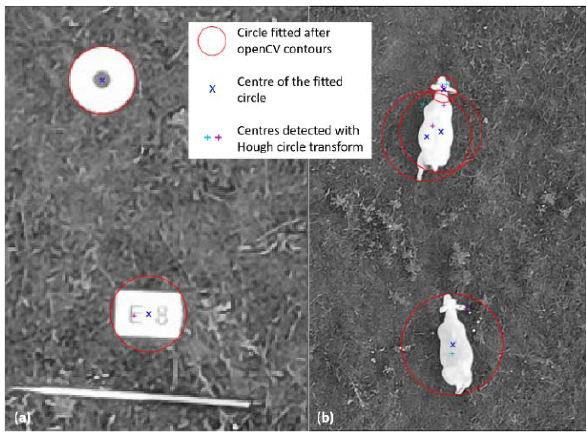
Figure 6. Examples of correct and erroneous target detections, the latter removed from the final outputs via the developed automated OpenCV workflow.